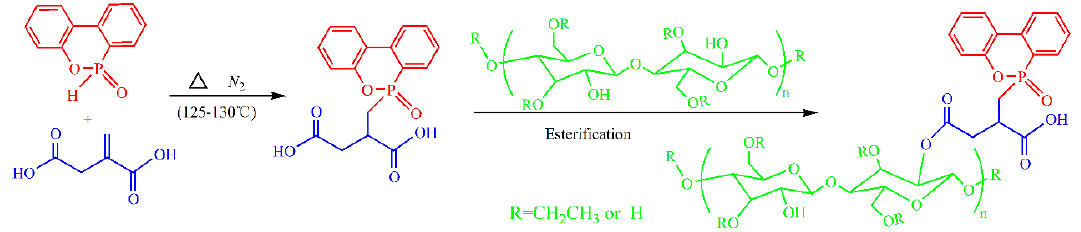
Figure 1. Scheme of DIMEC.